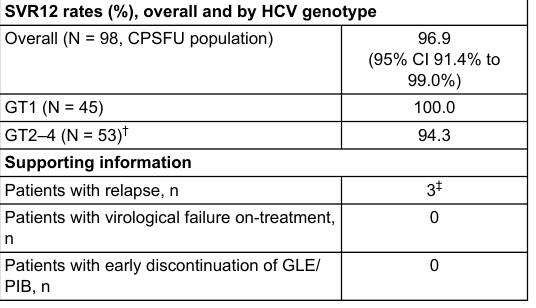
Table 2: Overview of treatment effectiveness of GLE/PIB in the Swiss cohort. SVR12 rates (%), overall and by HCV genotype